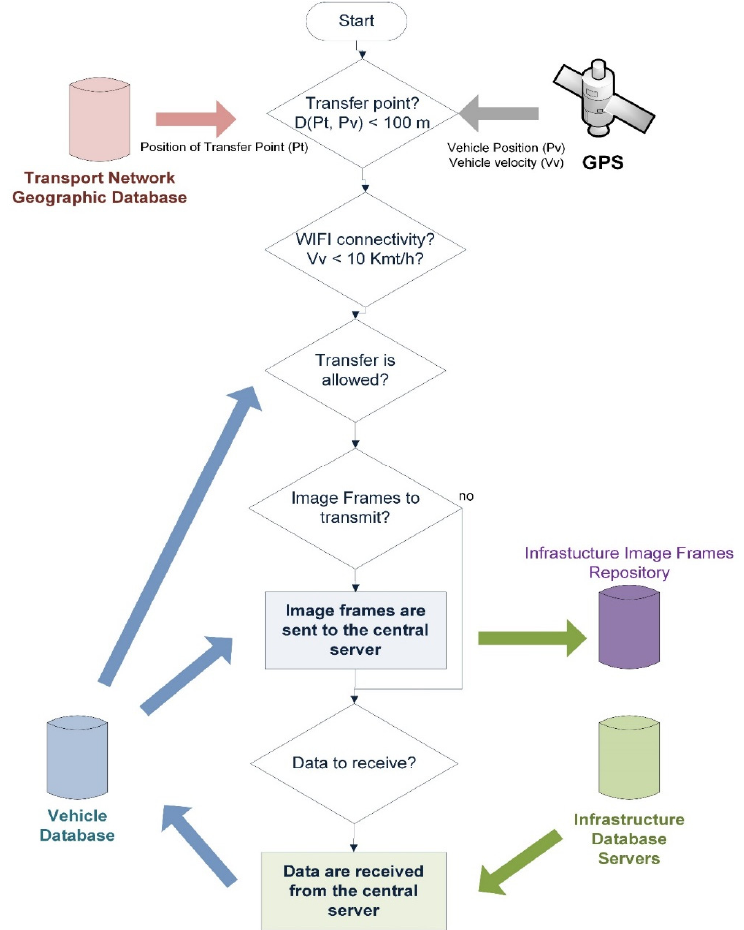
Figure 12. Flow diagram illustrating data transfer from vehicles to corporate repositories.